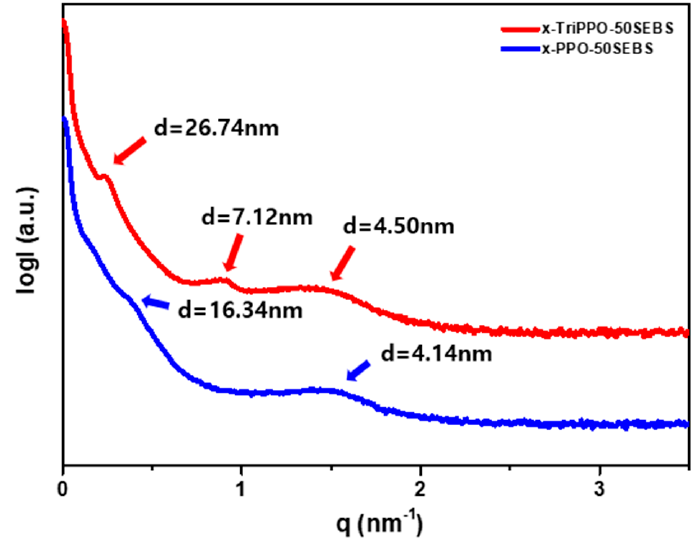
Figure 7. The crosslinked PPO − SEBS membranes’ SAXS